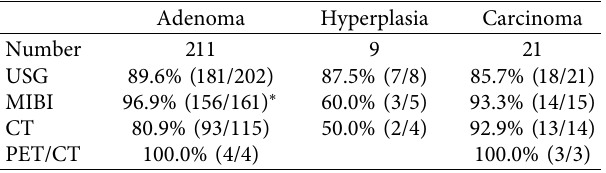
Table 6: Sensitivity of imaging methods in different PHPT path- ological